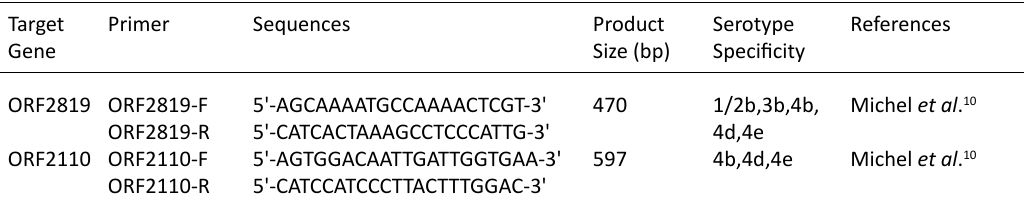
Table 2. Primers used for identification of L. monocytogenes serogroups Target Primer Sequences